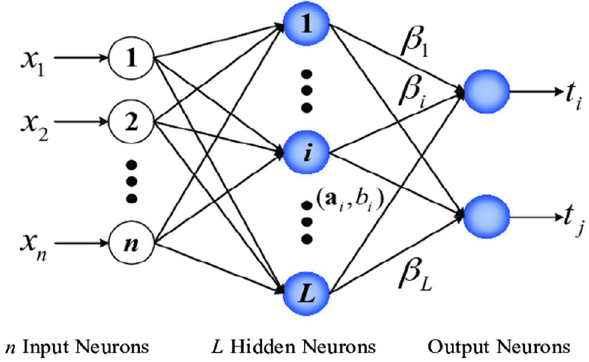
Fig. 4 ELM network